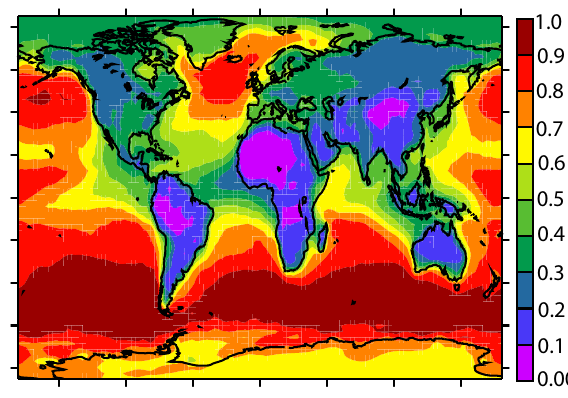
Fig. 2. Annual mean distribution of κ at the altitude of the planetary boundary